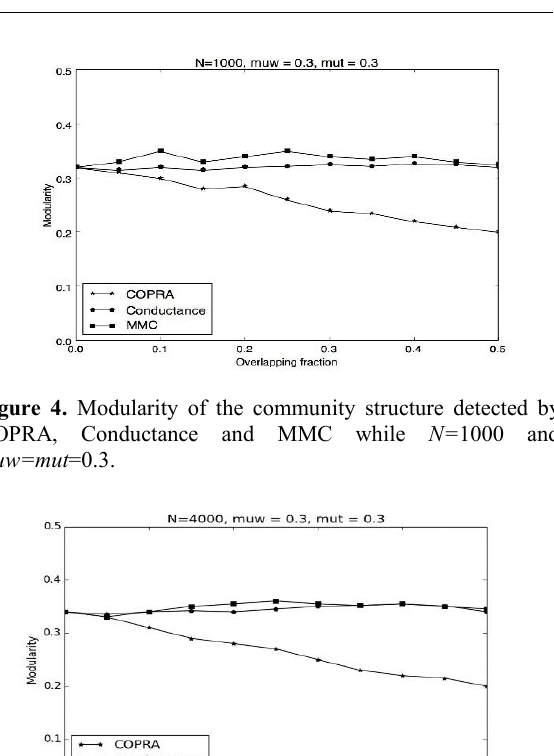
Figure 2. Modularity of the community structure detected by COPRA, Conductance and MMC while N =1000 and muw=mut =0.1.